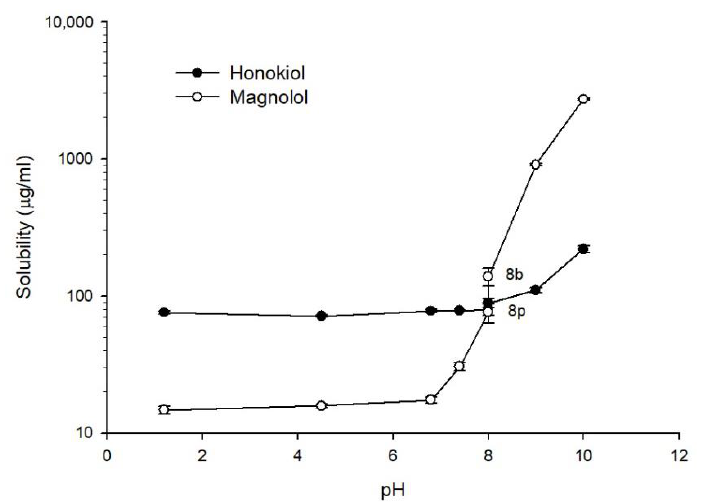
Figure 3. Solubility of magnolol ( buffer; pH 8b: borate